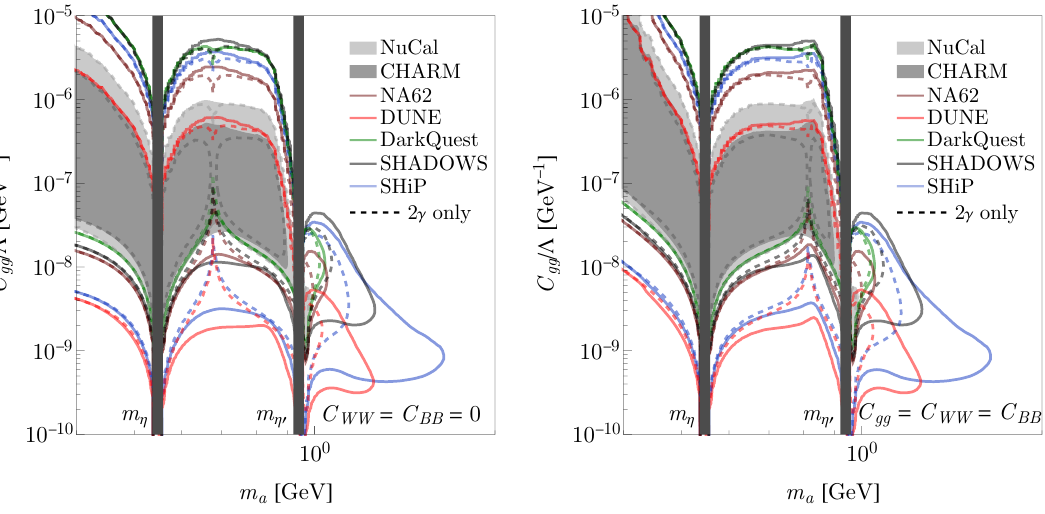
Figure 7 . 90% CL exclusions limits for scenarios (iii) (left) and (iv) (right) given by a di-gamma decay only search (dashed line), compared with the exclusion when all mentioned hadronic channels are also taken into account (full